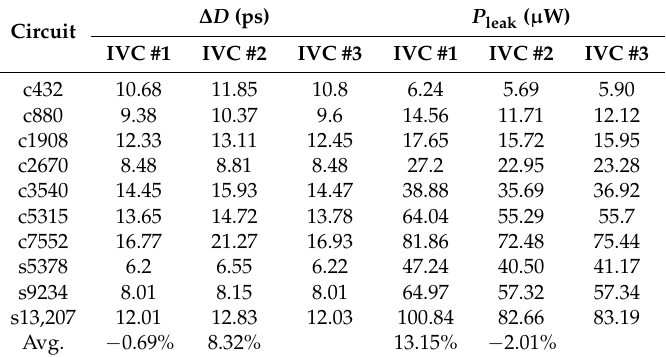
Table 4. NBTI and leakage reduction results using different kinds of ILP